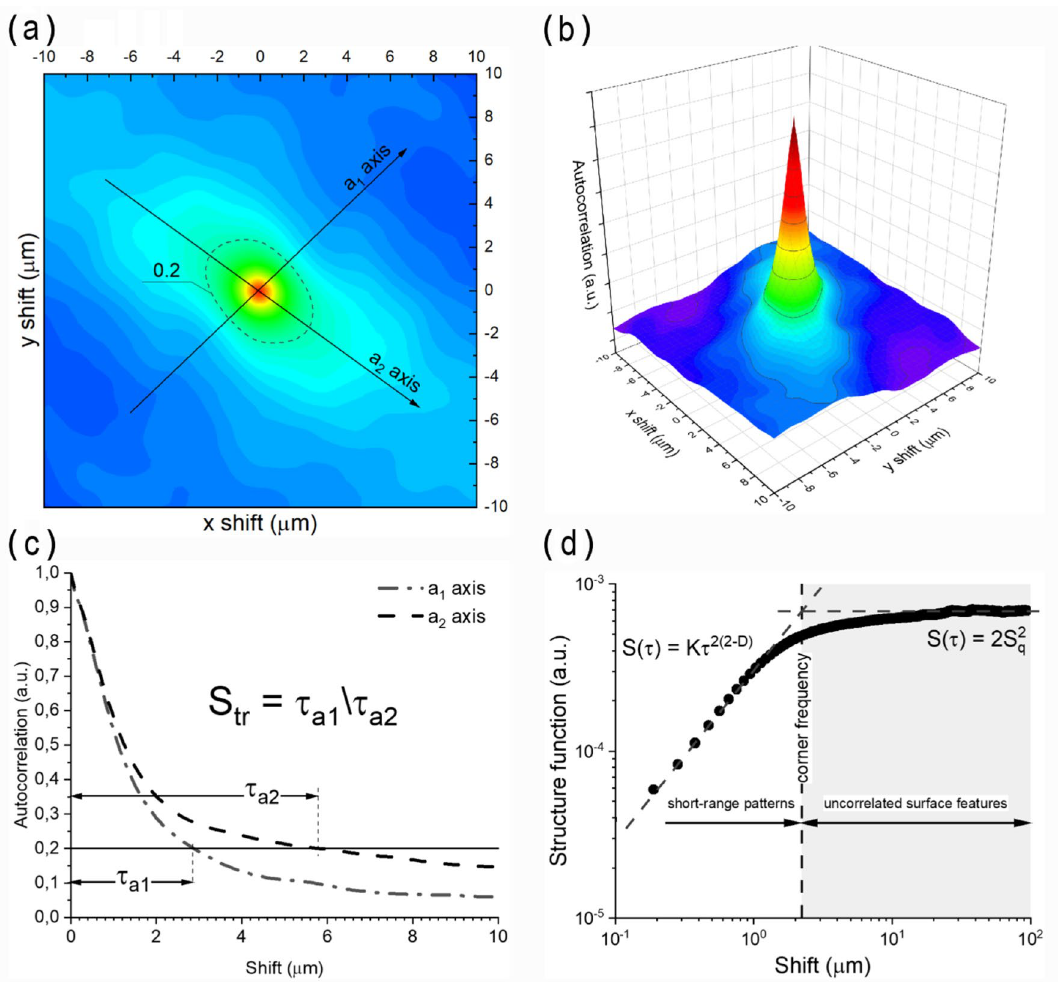
Figure 3. Example plots of autocorrelation and structure functions derived from SEM image shown in Fig. 1a: ( a ) plane projection of 2-dimensional autocorrelation function drawn with the axes of the fastest and slowest autocorrelation decays down to 0.2 value (a 1 and a 2 , respectively), ( b ) 3-dimensional autocorrelation function (main peak), ( c ) profiles of the autocorrelation function along a 1 and a 2 axes, ( d ) log–log plot of the structure